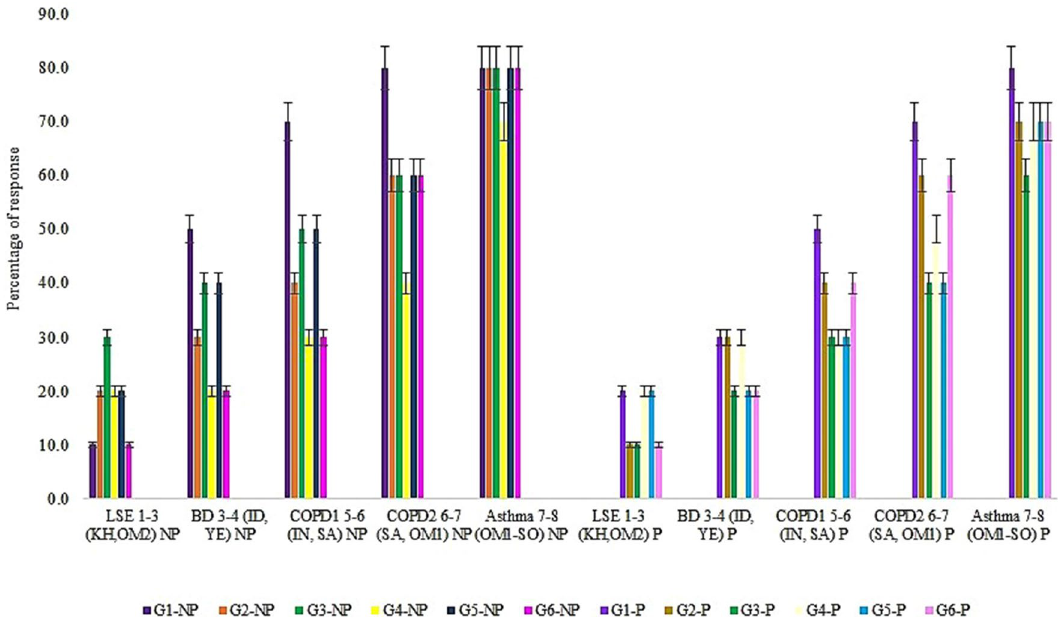
Figure 5. Governorate-wise type of incense causing respiratory ailments from non-perfumed and perfumed incense. LSE low symptomatic effect; BD breathing difficulty, COPD1 chronic obstructive pulmonary disease (cough); COPD2 chronic obstructive pulmonary disease-(emphysema); G1–G6 Governorate